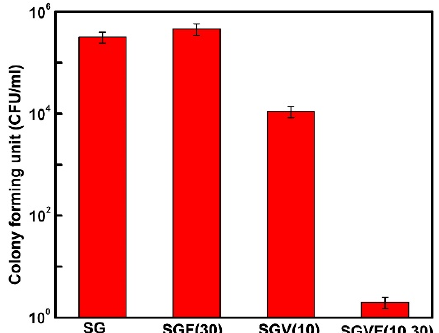
Figure 1. The anti ‐ methicillin ‐ susceptible S. aureus growth effect of thin sol–gel films containing vancomycin and farnesol, coated on Ti rods [52]. Reprinted with permission from (Biomaterials). Copyright (2014) Elsevier.